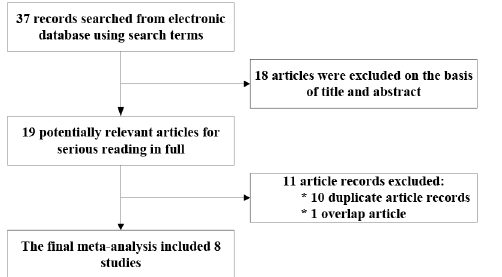
Fig 1. Flowchart depicting the selection of articles for the